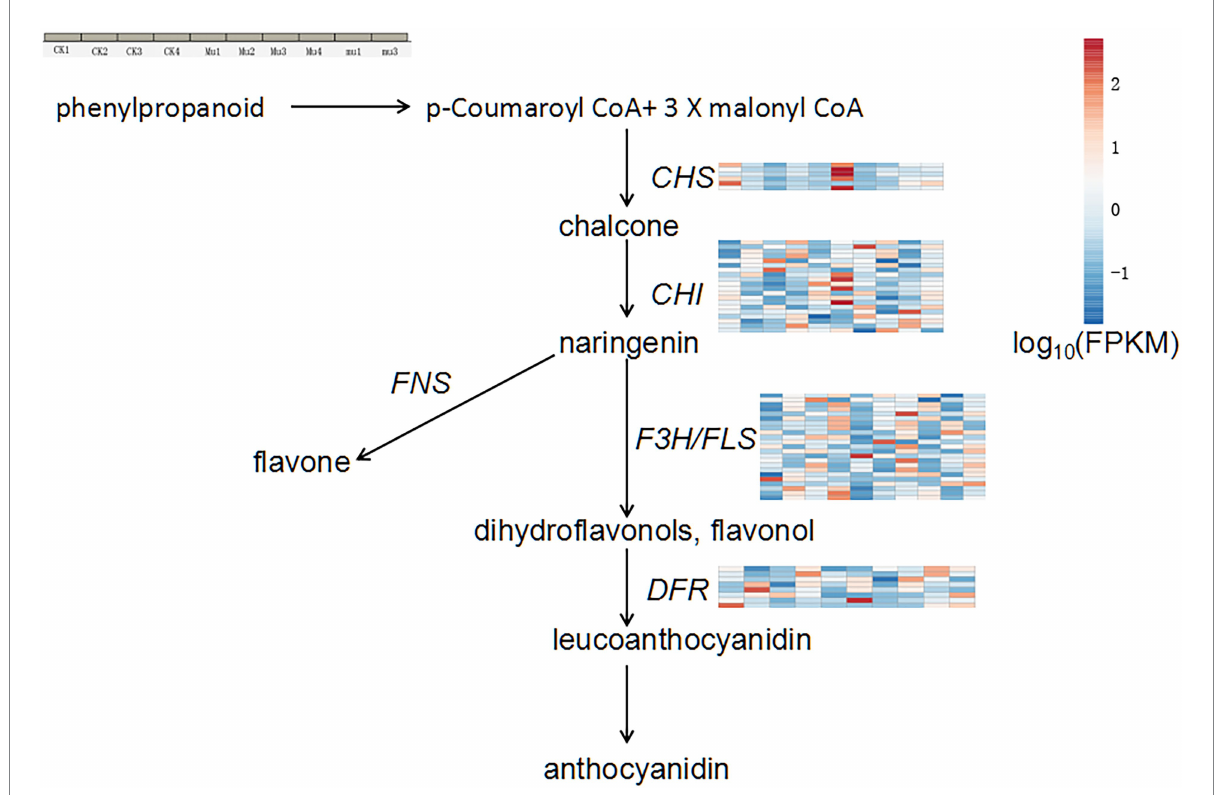
FIGURE 6 General anthocyanidin synthesis pathway and expression profile of DEGs involved in the pathway. Gene expression is normalized using FPKM and represents the means of three biological replicates. Expression values are presented as FPKM normalized log10-transformed counts. The color represents relative gene expression levels. While the horizontal direction shows the sample names, the vertical direction shows the names of genes involved in osmotic regulation. CHS, chalcone synthase; CHI, chalcone isomerase, F3H, flavanone 3-hydroxylase; FNS, flavone synthase; FLS, flavonol synthase; DFR,